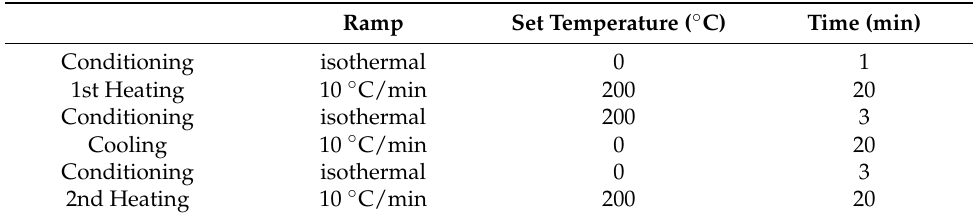
Table 2. Conditions for measuring thermal